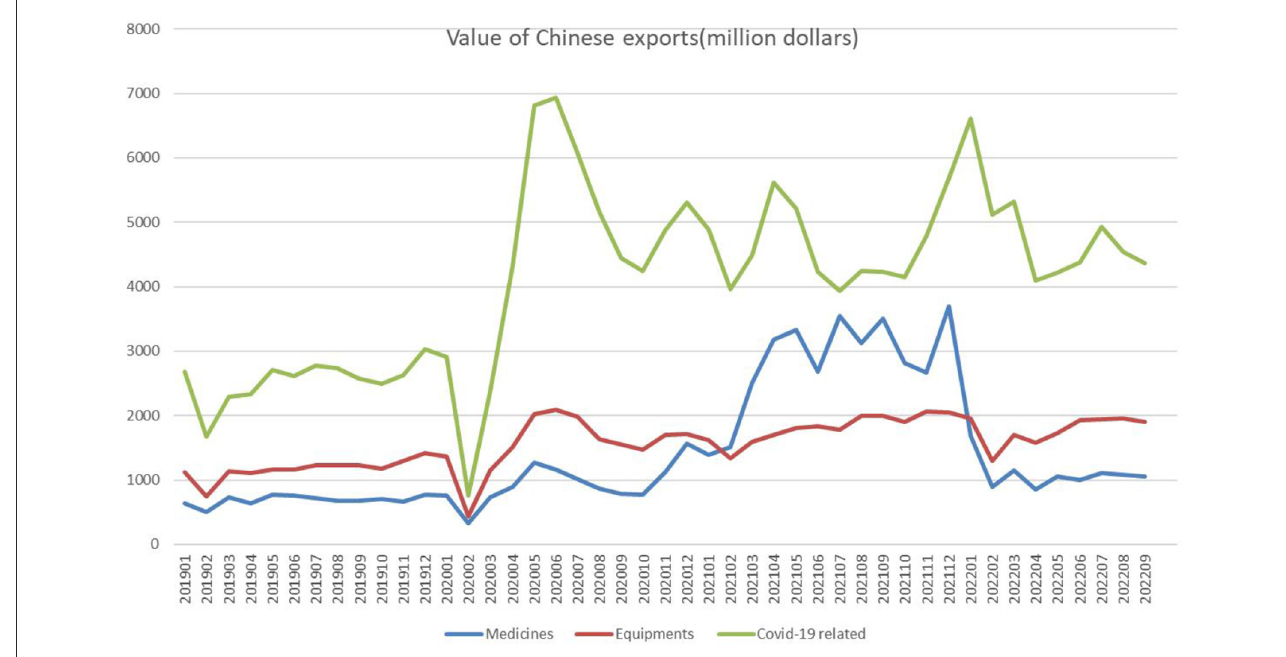
FIGURE1 Chinese exports of medical goods. Source: Authors’ computations using data from China’s general administration of customs.